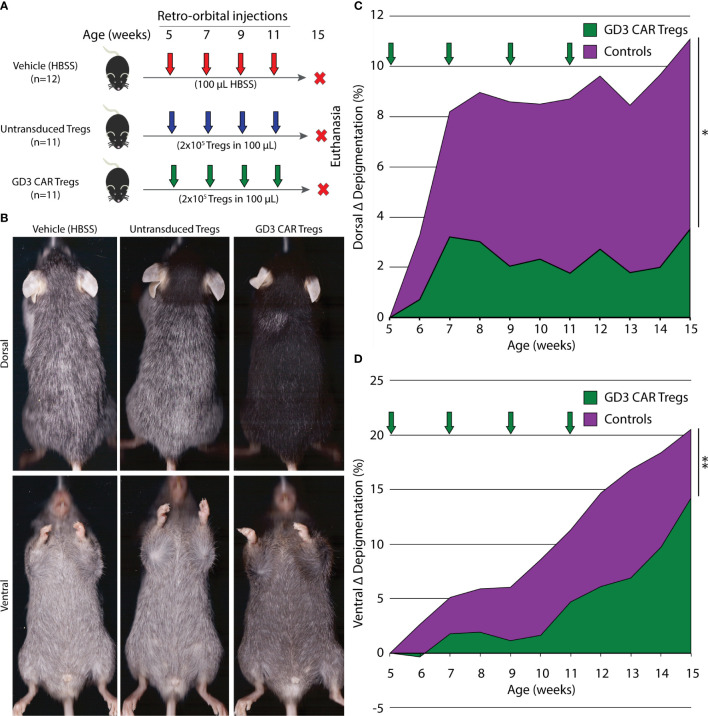
GD3 CAR Tregs provide significant protection from depigmentation in vitiligo-prone mice. (A) Experimental outline initiated at 6 different time points showing vitiligo prone, h3TA2, mice treated with vehicle alone (n = 12), or by adoptive transfer of untransduced Tregs (n = 11) or GD3 CAR Tregs (n = 11). Adoptive transfer started at 5 weeks of age and continued biweekly until 11 weeks of age. Depigmentation was measured weekly from 5–15 weeks of age. (B) Representative dorsal and ventral scans of mice from the HBSS vehicle, untransduced Treg, and GD3 CAR Treg treated groups at 15 weeks of age. (C) Depigmentation quantified on dorsal and (D) ventral sides throughout the experiment. The Wilcoxon rank sum (WRS) test was used to compare the time-adjusted AUC among groups. Arrows: treatment times. *p < 0.05; **p < 0.01.